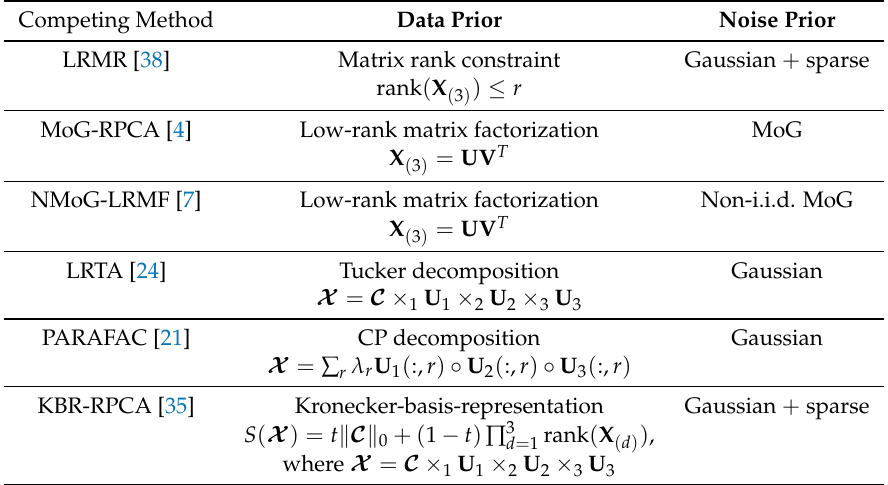
Table 1. Summary of competing methods. Here × d denotes the d -mode product [19], and ◦ denotes the vector outer